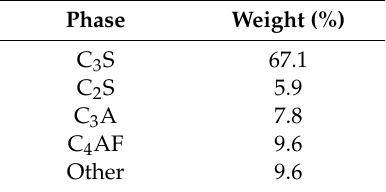
Table 1. Mineral composition of Portland cement (% by weight).